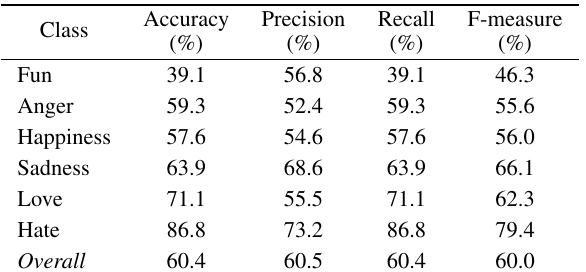
6-class classification of tweets of 6 classes.